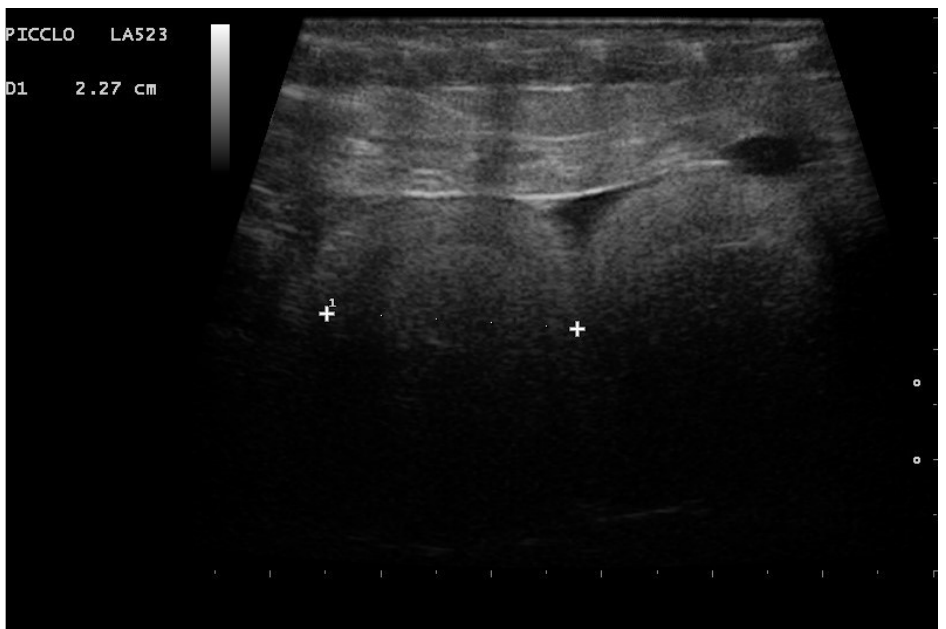
Figure 4. Follicle with an onion-ring appearance in a female during coupling. A concentric ultrasound appearance was recognizable in 90% of females.